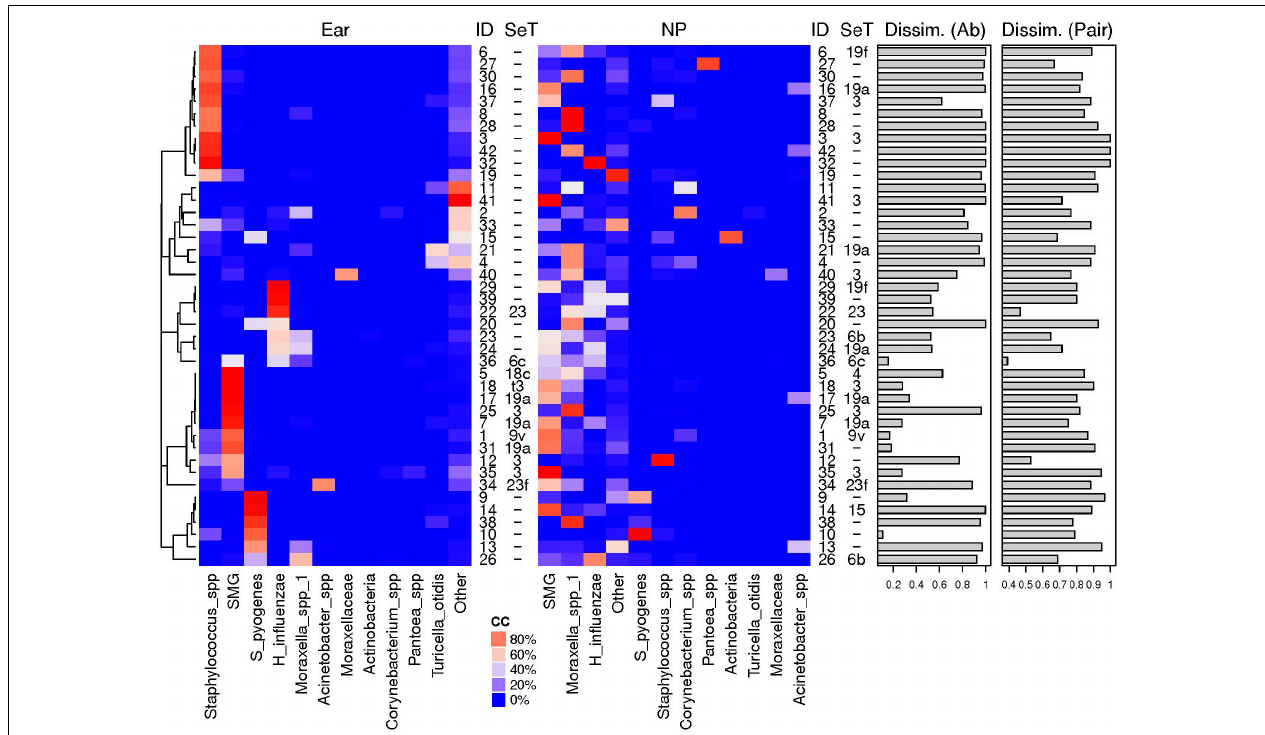
FIGURE 4 | Relative abundances of most abundant OTUs in MEF from ear and NP. Shown are the heat maps of the relative abundances of the most abundant OTUs in % [illustrated by a distinct color code (CC)]. The pneumococcal serotpyes (SeT) are indicated. Dissimilarly values based on abundance based Ružiˇcka (Dissim. Ab) and presence-absence based Jaccard (Dissim. Pair) distance values between the two different sample types of the same individual (ID) are shown as bar plots. High similarity of the bacterial microbiota of NPS and MEF when S. pyogenes , H. influenzae or S. pneumoniae were the predominant OTUs and overall high negative predictive values for NPS based prediction of MEF (see Table 2 and text for more details). SMG, Streptococcus mitis group members (including Streptococcus pneumoniae